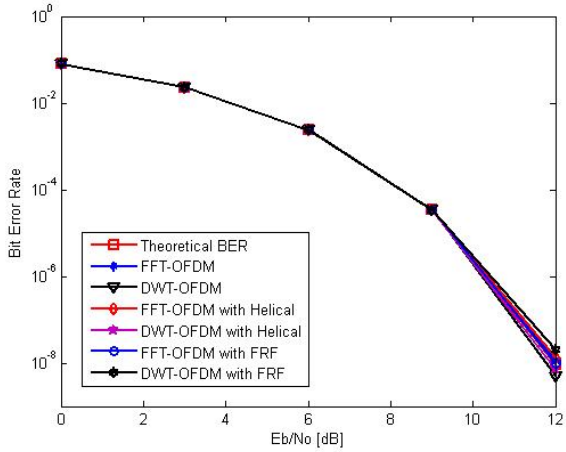
Figure 8. FFT − OFDM and DWT − OFDM BER performance over AWGN